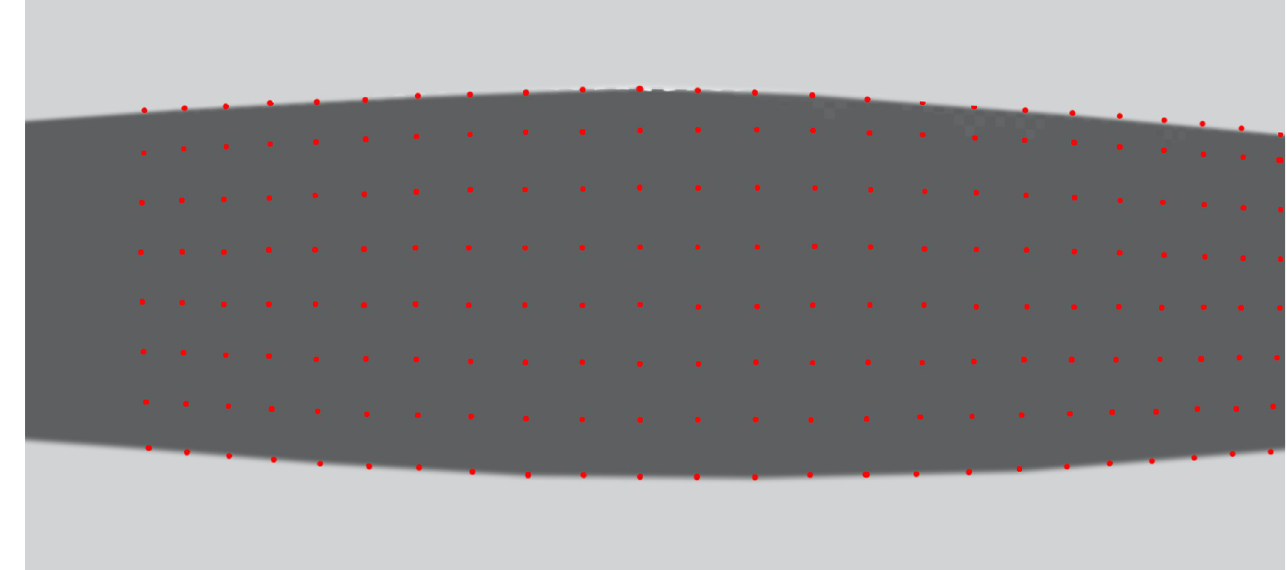
Fig 2. Calibration grid. Camera view of the calibration grid on the floor (red points).